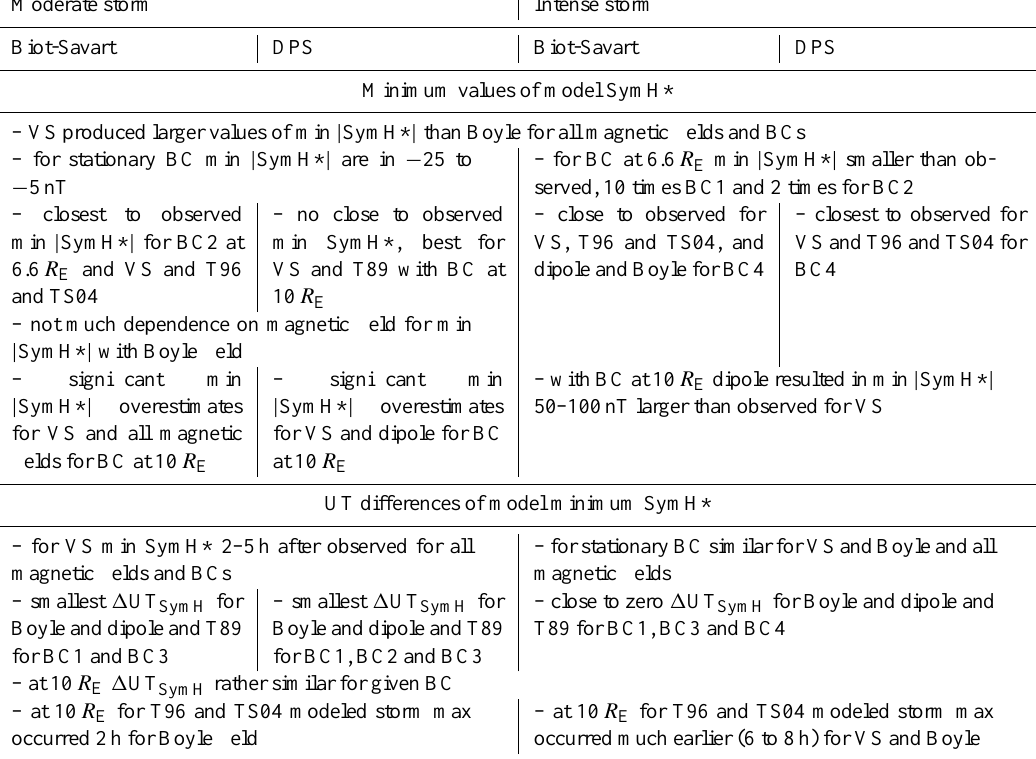
Table 4. Model-dependent storm-time ring current: minimum values and their UTs of model SymH*. Moderate